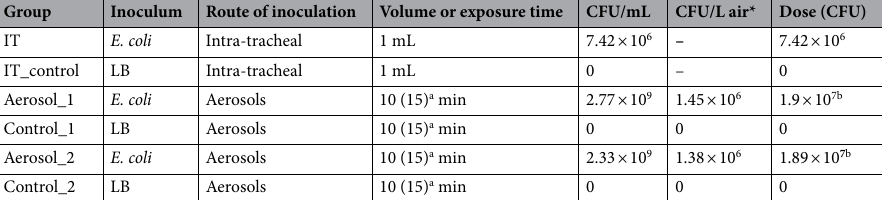
Table 3. Exposure. *Mean of the obtained air samples collected in duplicate at two rounds of exposure of n = 10 birds. a The time period provided in brackets encompasses the total time-length the animals spend in the aerosol chamber, i.e., exposure and ventilation time. b Anticipated inhaled dose. CFU colony forming unit, E. coli Escherichia coli, IT intratracheal, LB Lysogeny broth, min. minutes.